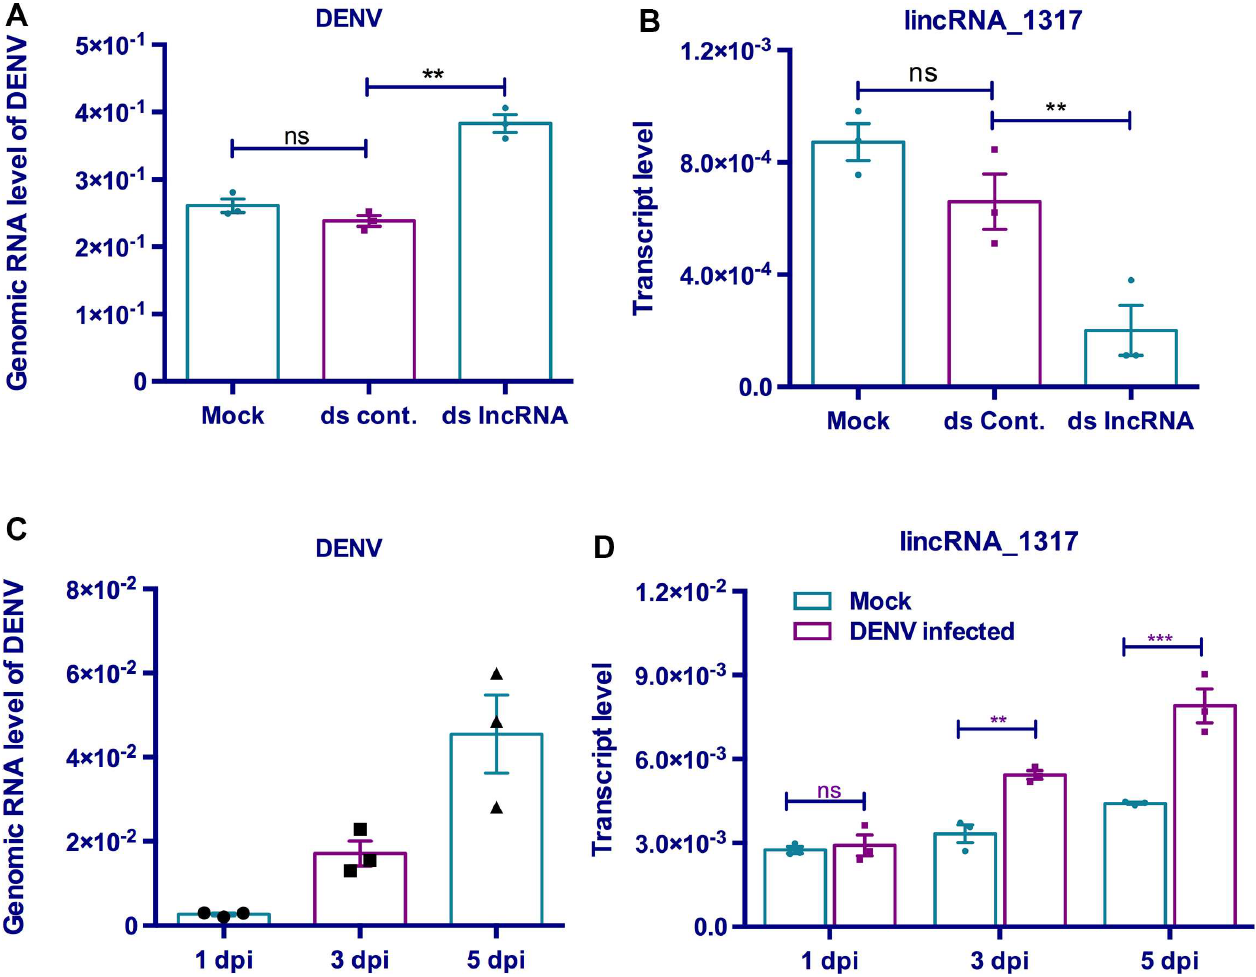
Fig 7. Possible involvement of lincRNA_1317 in DENV-2 replication in Ae . aegypti Aa20 cells. A) Aa20 cells were doubletransfected with the transfection reagent only (Mock), dsRNA to GFP (dsCont) or dsRNA to lincRNA_1317 (dslncRNA) for three days followedby 1 MOI infection of the cells with DENV-2. Primers to the NS2A region (S1 Table) were used for measuringthe relative DENV-2 genomic RNA levels. B) RNAi silencingof lincRNA_1317 using dsRNA was confirmed by RT-qPCR. C) Changesin DENV-2 genomic RNA levels during the course of infection analyzedby RT-qPCR on RNA extracted from Aa20 cells at 1, 3 and 5 days post-infection(dpi). D) DENV-2 infection increasedthe transcript levels of Ae . aegypti lincRNA_1317 in 3 rd and 5 th days post-infectionwhen RNA from cells were analyzedby RT-qPCR. In all the experiments shown in this figure, three biologicalreplicates, each with three technicalreplicates were used. ** , p < 0.01; *** , p <